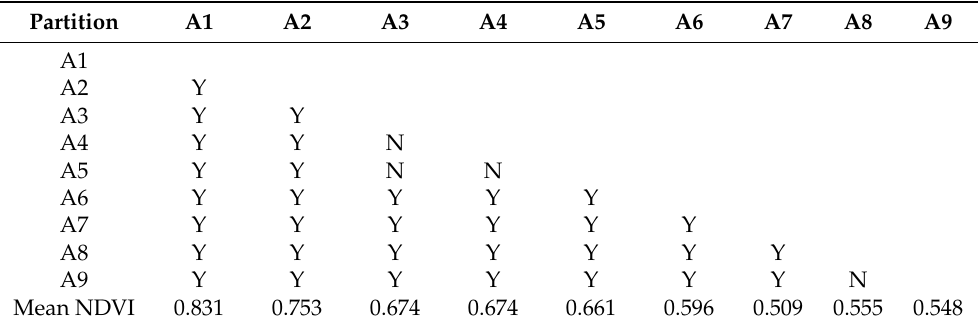
Table 7. Mean NDVI and statistical significance for every two divisions of GDP (95% confi- dence